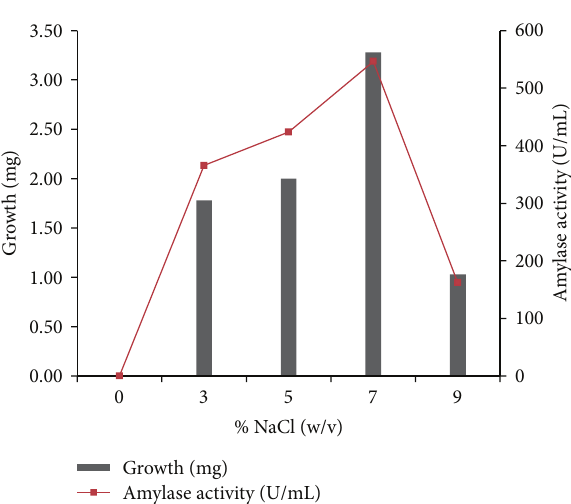
Figure 7: Effect of NaCl concentration on growth and amylase